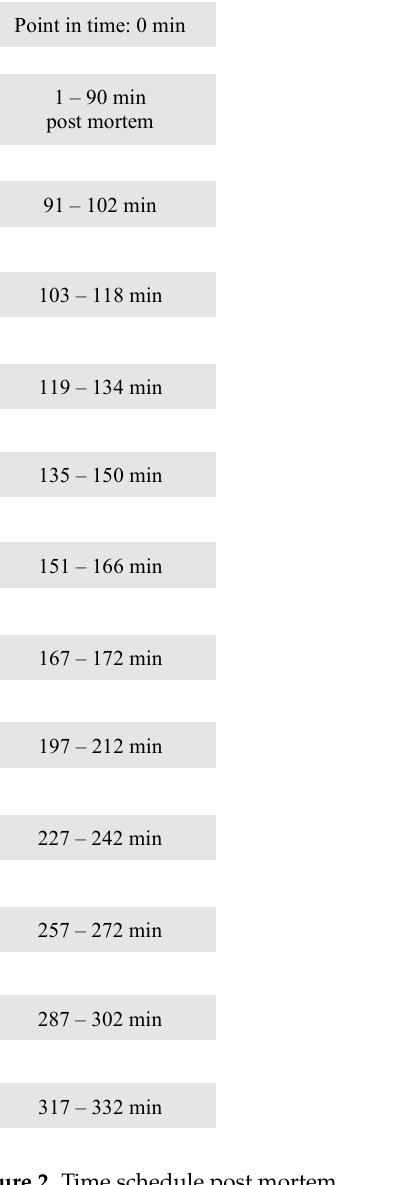
Figure 2. Time schedule post mortem .